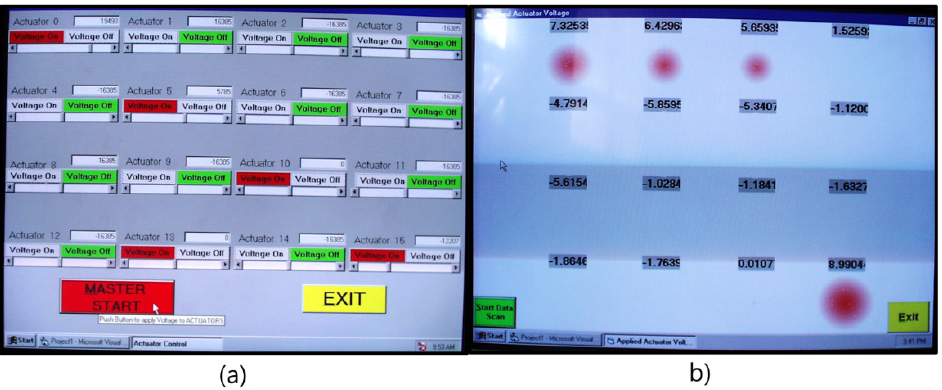
Figure 3. Computer display for the 16 (4×4) actuators’ control: (a) control panel of the basic program and (b) an example of display output.